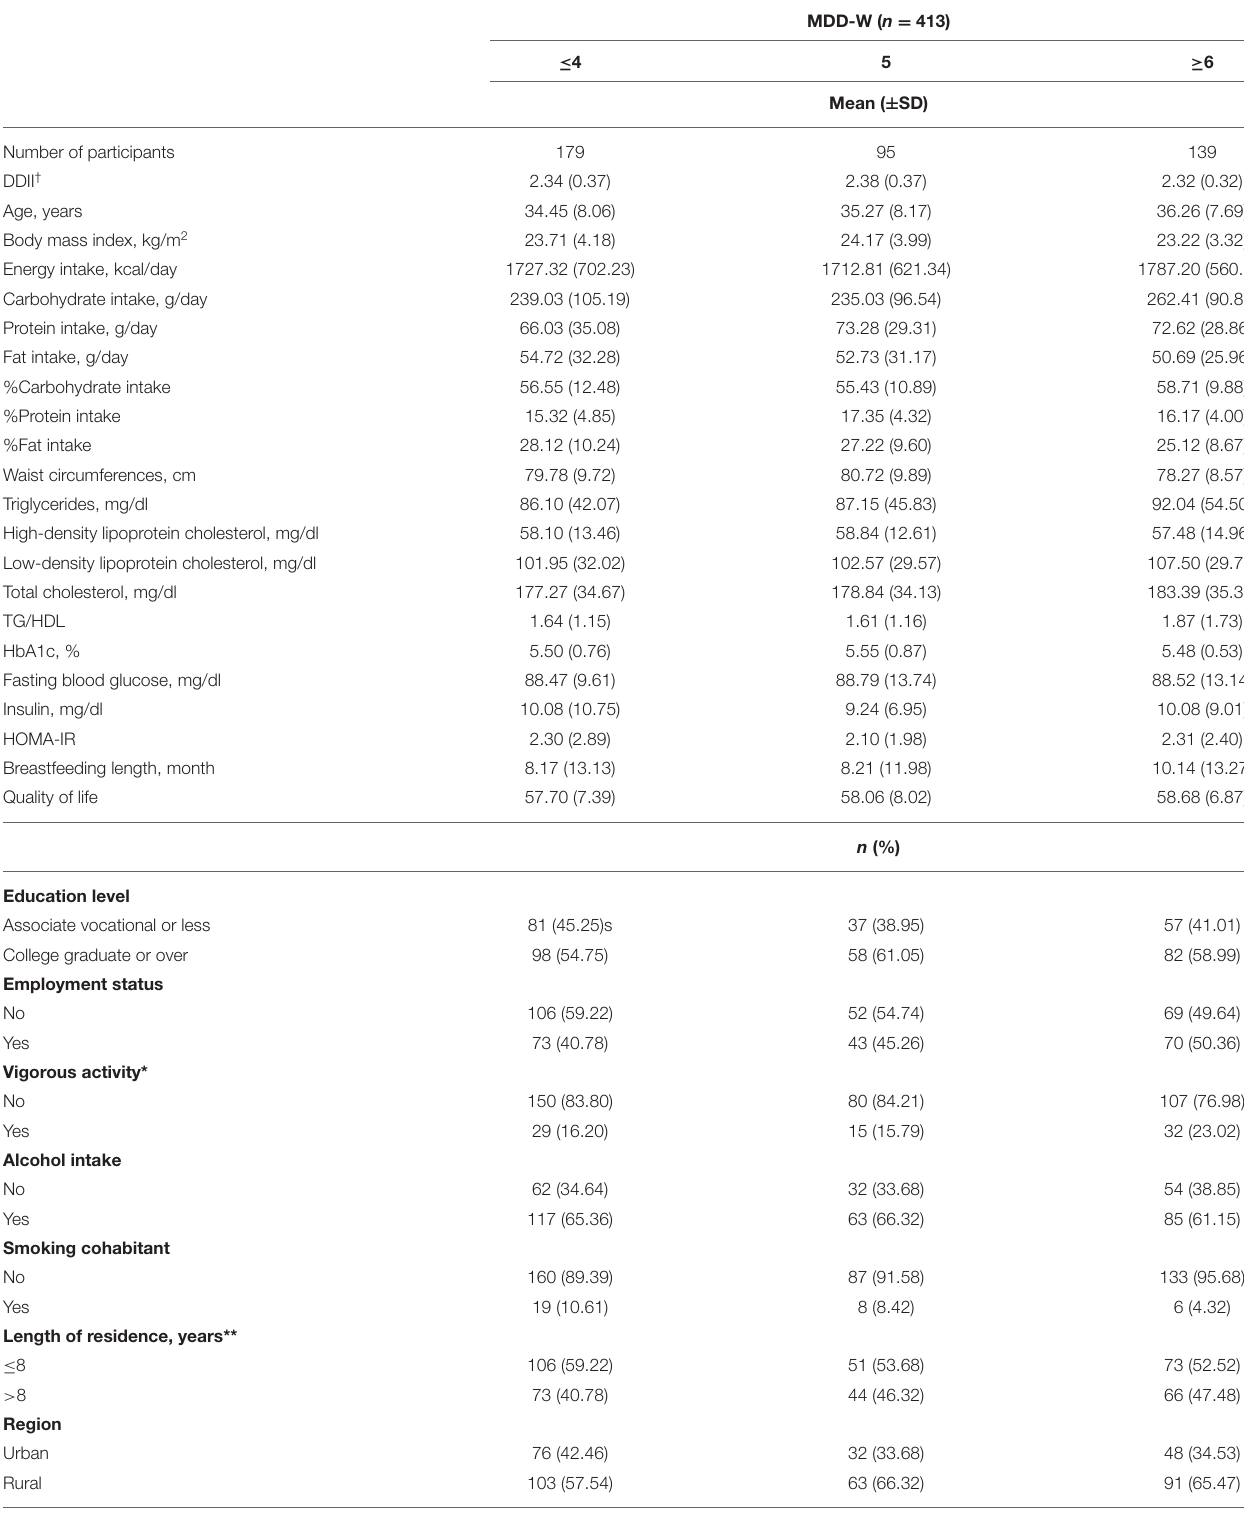
TABLE 1 | Baseline characteristics according to the tertiles of MDD-W in the FiLWHEL